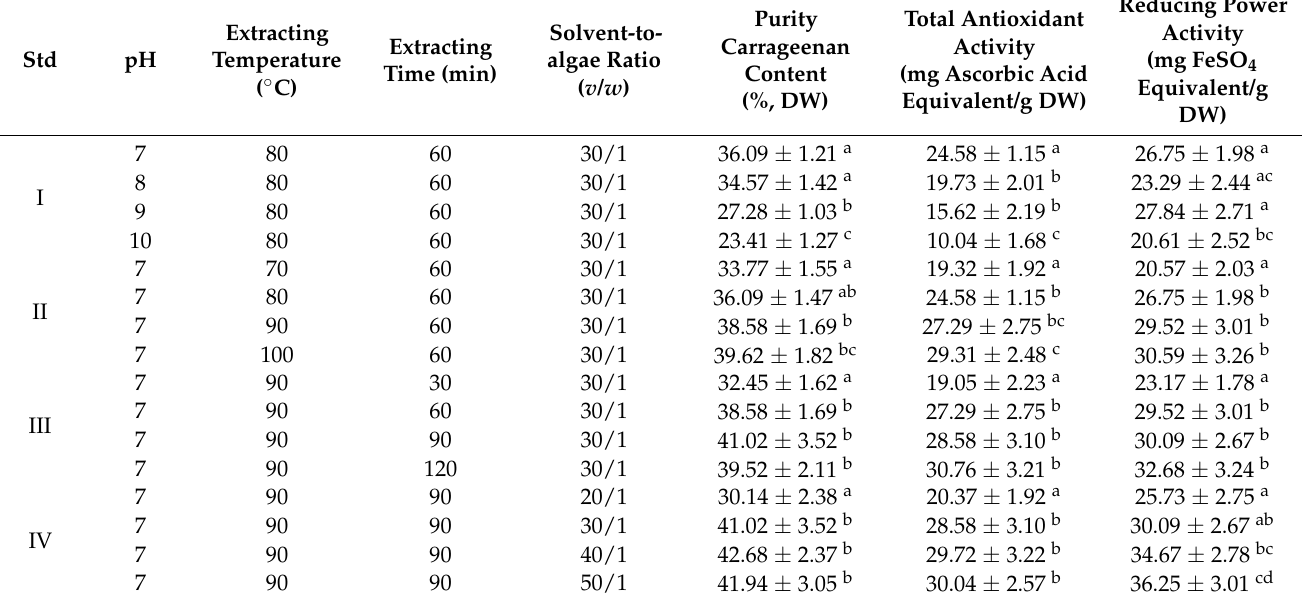
Table 1. Effect of the extraction condition on purity carrageenan content and its antioxidant